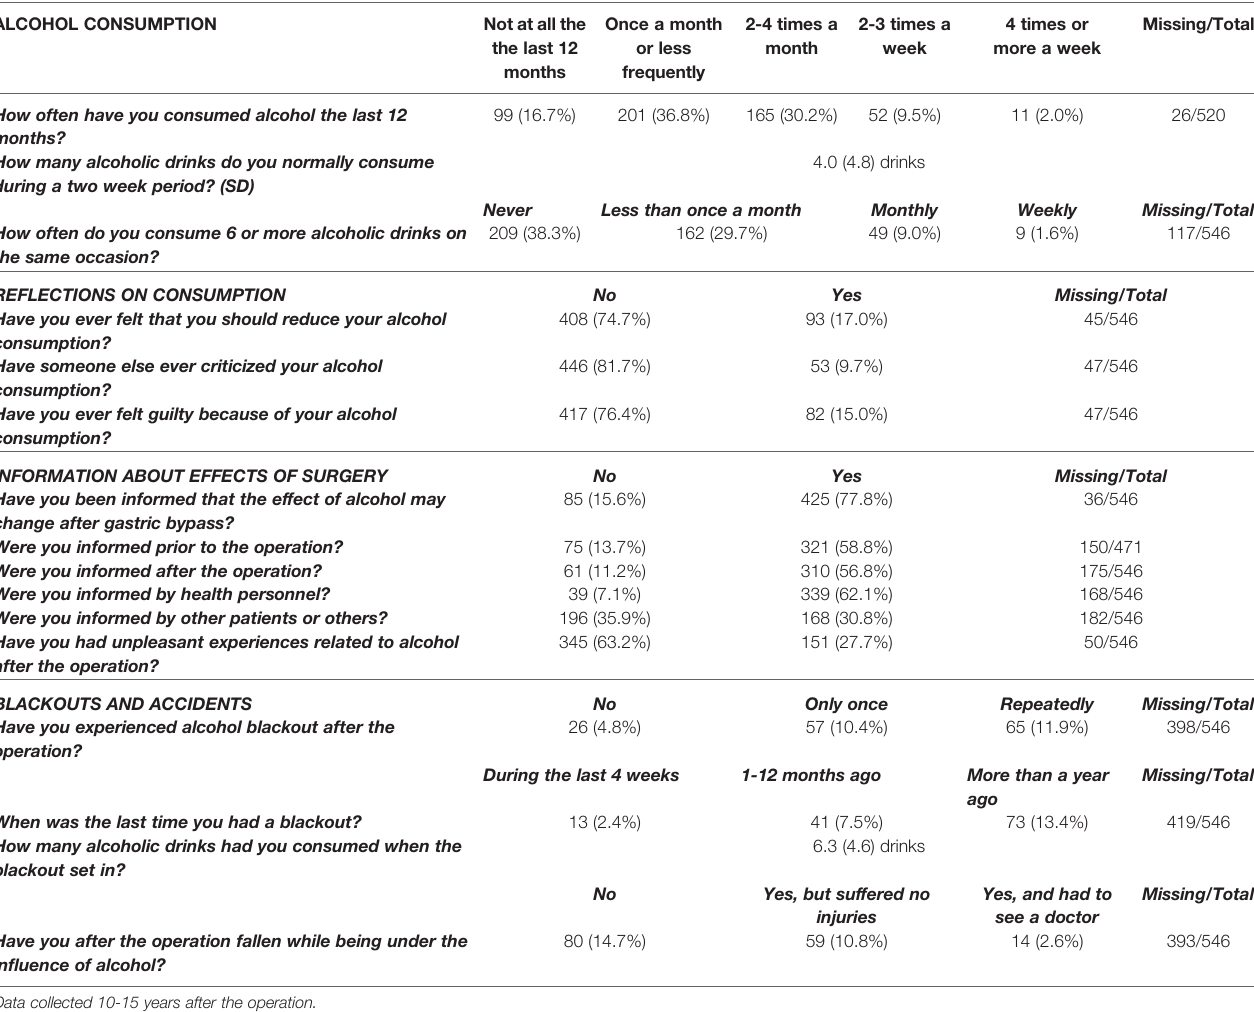
TABLE 1 | Self-reported data on drinking behaviour from 546 patients who had undergone Roux-n-Y gastric